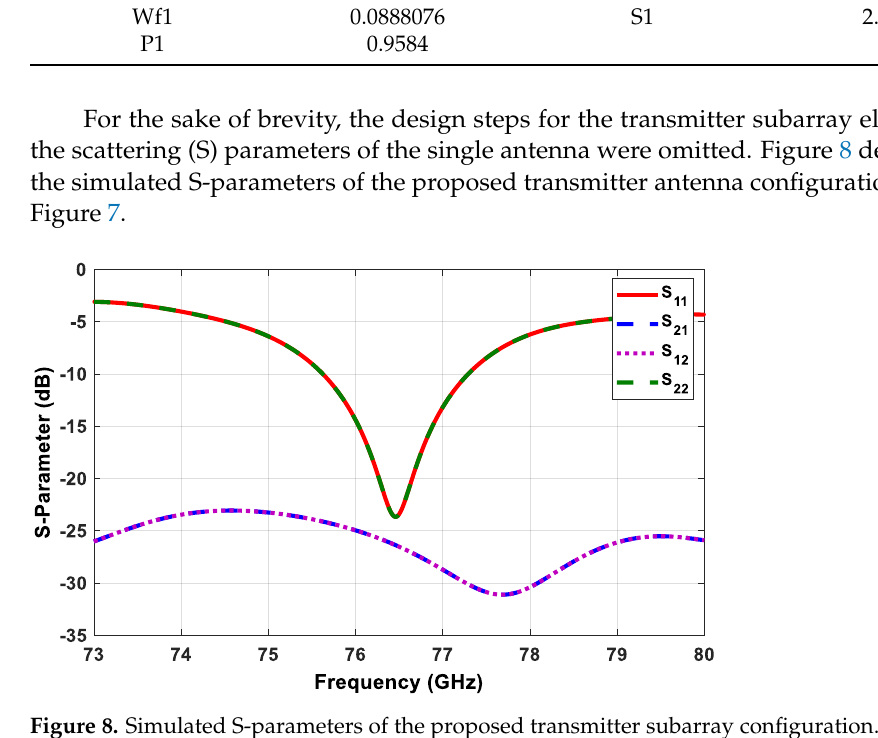
Figure 8. Simulated S-parameters of the proposed transmitter subarray configuration.